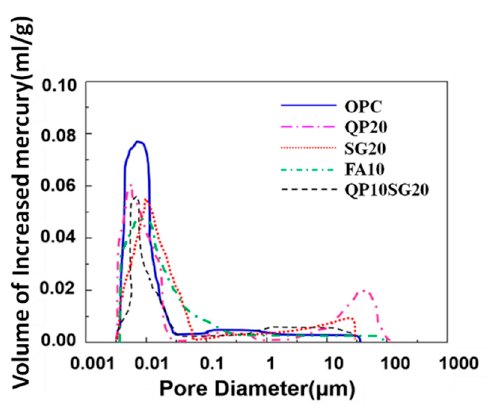
Figure 7. Pore distribution and pore diameter.